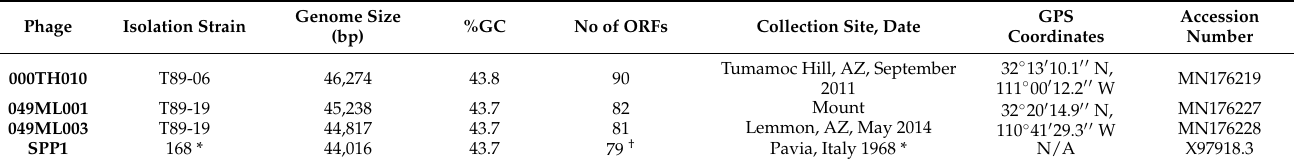
Table 1. Basic genomic characteristics of three Bacillus subtilis phages related to SPP1 as well as SPP1. ORF = Open Reading Frame signifying either known or putative genes. * = information from [24]; † = the two holin genes with an in-frame internal initiation codon were only counted once; N/A = Not